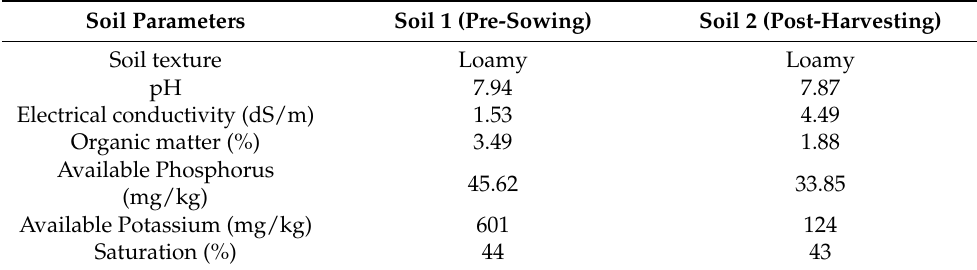
Table 1. Physicochemical properties of soil.